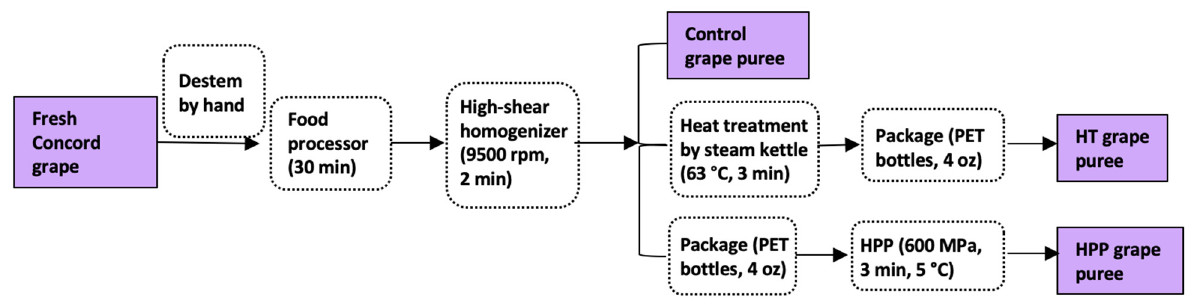
Figure 1. Flow diagram for the production of whole Concord grape puree.